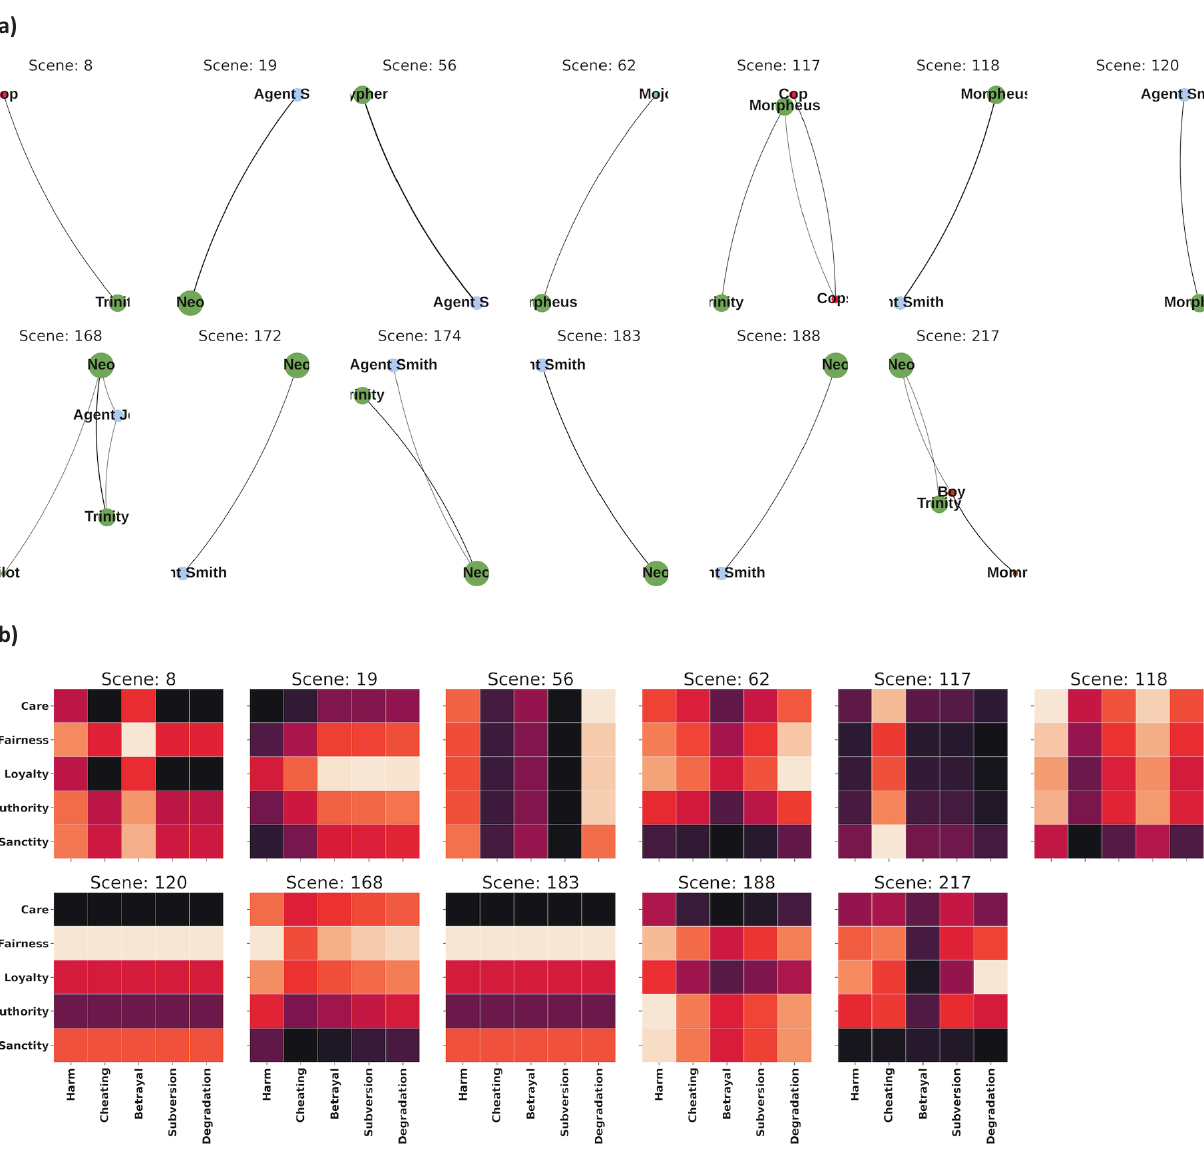
Figure 6. Moral conflict in The Matrix : (a) Cross-module scenes and character interaction networks; (b) Moral conflict ma- trices. Notes: Two cross-module scenes (172 and 174) were discarded for moral conflict computations as no moral content was identified. Source: